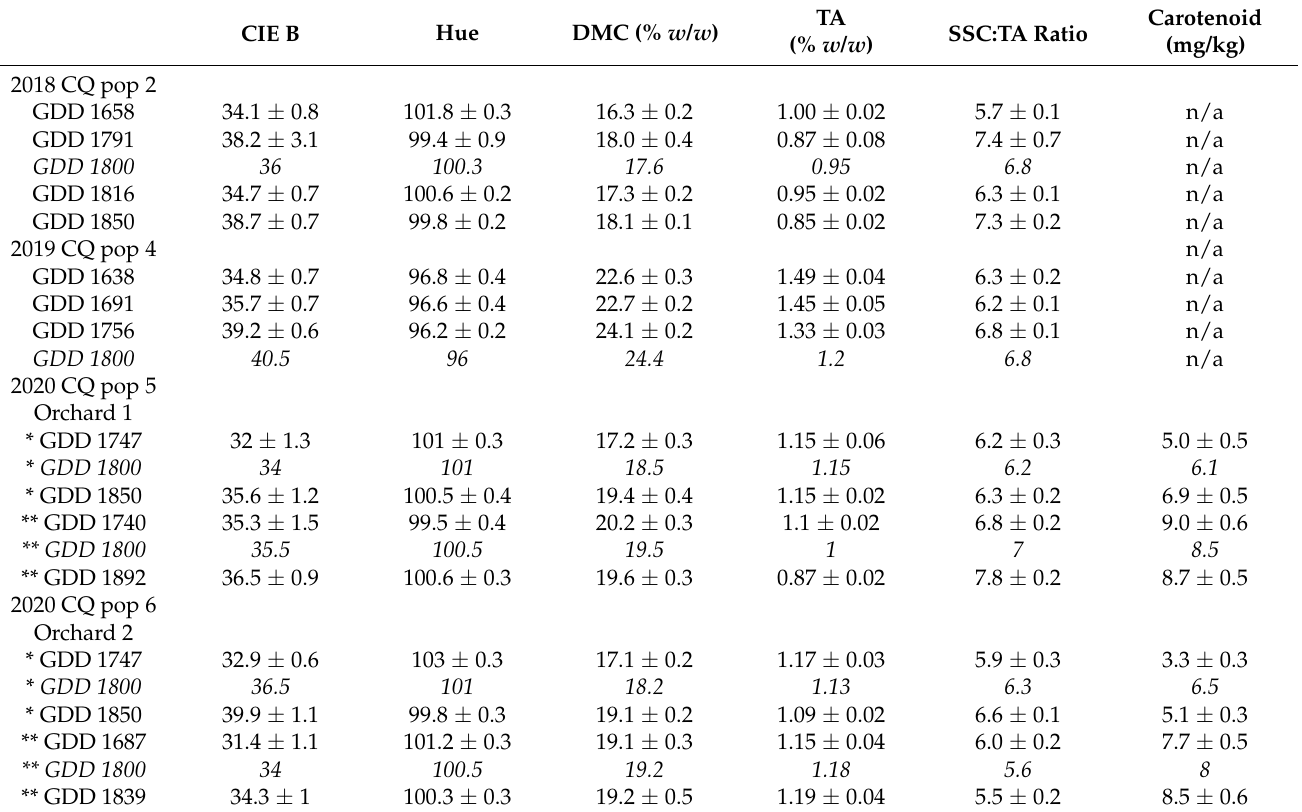
Table 9. Observed values of Honey Gold fruit attributes at several harvest dates bracketing the GDD (Tb = 12 ◦ C) target of 1800 units from asparagus stage, and values at the target value, in italics, as estimated by interpolation or extrapolation. Panicles were tagged at asparagus stage on different dates. Population numbers refer to Table 4. ‘n/a’ is not